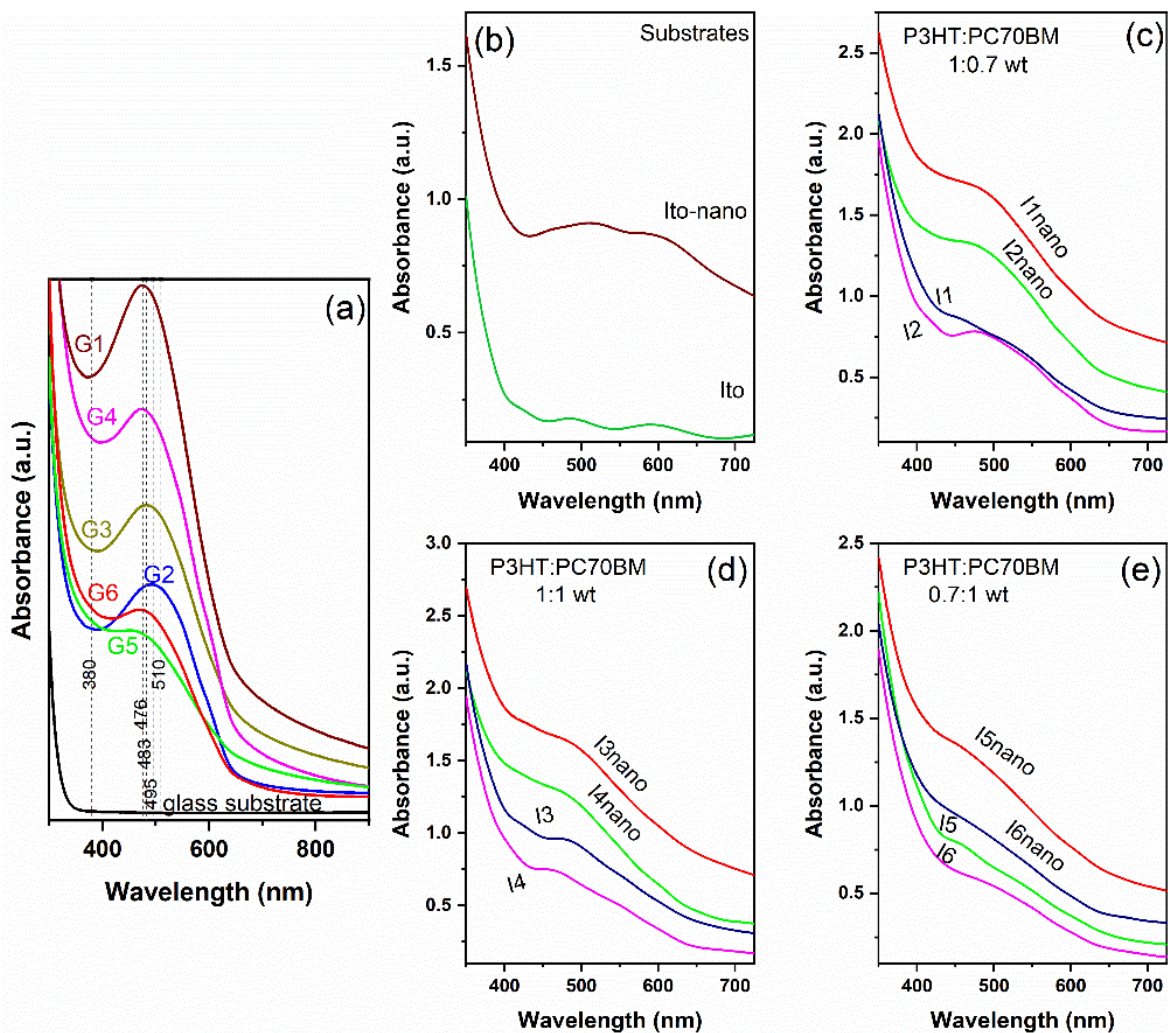
Figure 7. UV-VIS spectra of: ( a ) the thin films deposited on glass substrate by MAPLE (G1–G6), ( b ) flat and patterned ITO substrates and ( c – e ) thin films deposited on flat and patterned ITO substrates by MAPLE from targets with different P3HT:PC70BM weight ratio; the index indicates the samples (according to Table 2).